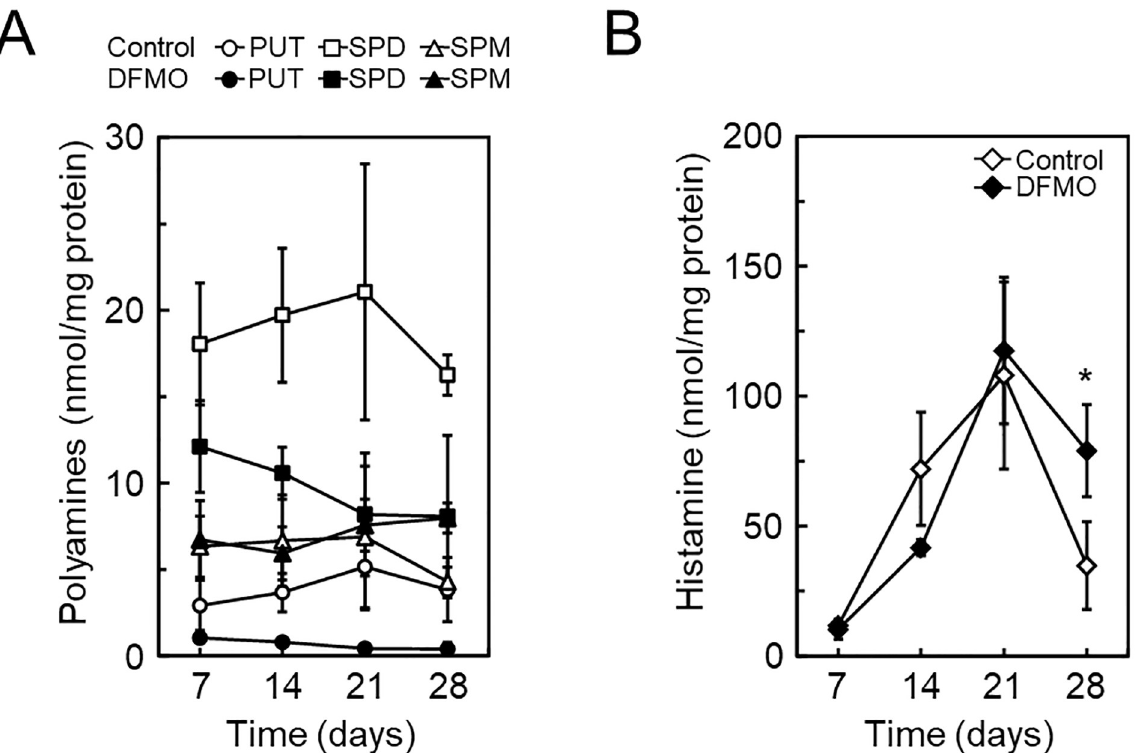
Fig 2. Polyamine and histamine levels during BMMC differentiation in the absence or presence of DFMO. During BMMC differentiation, cells on day 7, 14, 21, and 28 were used for analysis of intracellular polyamine (A) and histamine (B) content by HPLC. Mean ± s.d. is shown, n = 3 replicates. � p < 0.05, compared with